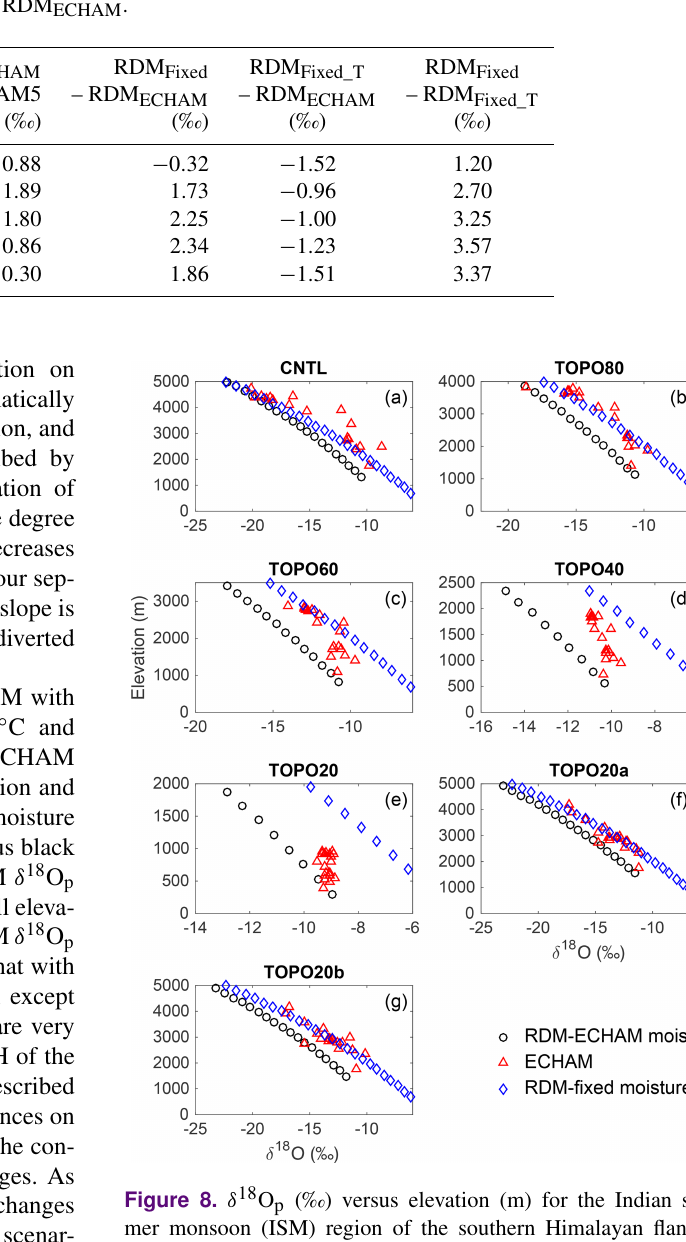
Table 1. Contribution of physical processes to annual-mean precipitation-weighted δ 18 O p (all units in ‰) averaged over monsoonal regions (IM and EASM). In the table, RDM ECHAM represents the RDM initiated using the moisture sources (i.e., air temperature and relative humidity) from ECHAM5; RDM Fixed is the δ 18 O p simulated by a RDM initiated with fixed moisture source of T = 20 ◦ C and RH = 80%; and RDM Fixed_T is initiated with fixed T = 20 ◦ C and ECHAM RH (refer to Sect. 2.2 for more details on the three different moisture sources). All columns show values averaged from mountain foot to mountain peak, except for the second column that shows the difference in δ 18 O p between mountain peak and foot as simulated by RDM ECHAM .